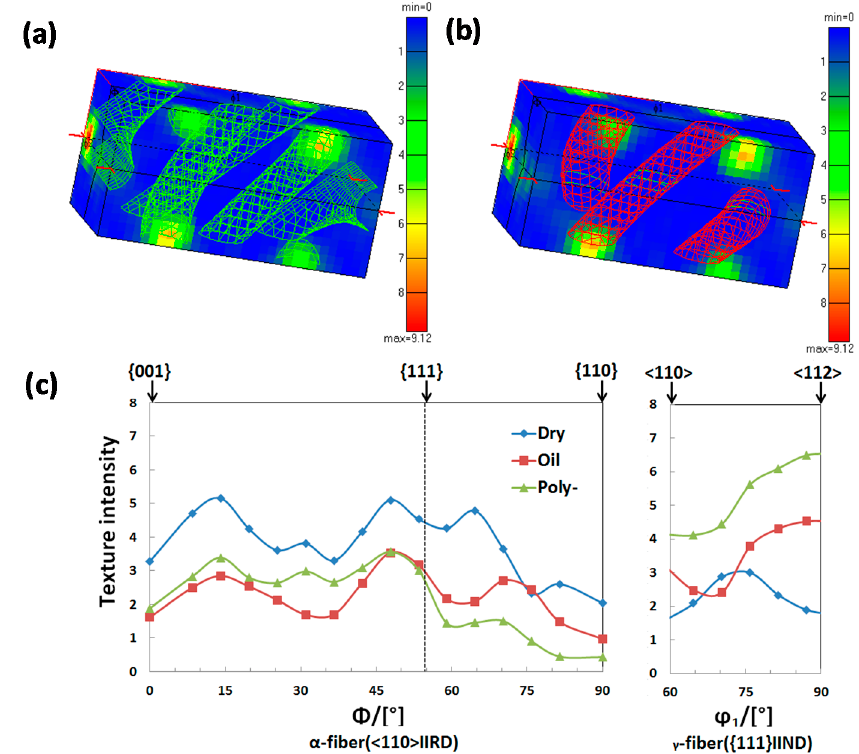
Figure 7. Ideal orientation of ( a ) <110> and ( b ) <111> in Euler space and ( c ) texture intensity along the α -fiber and γ -fiber at 700 °C.